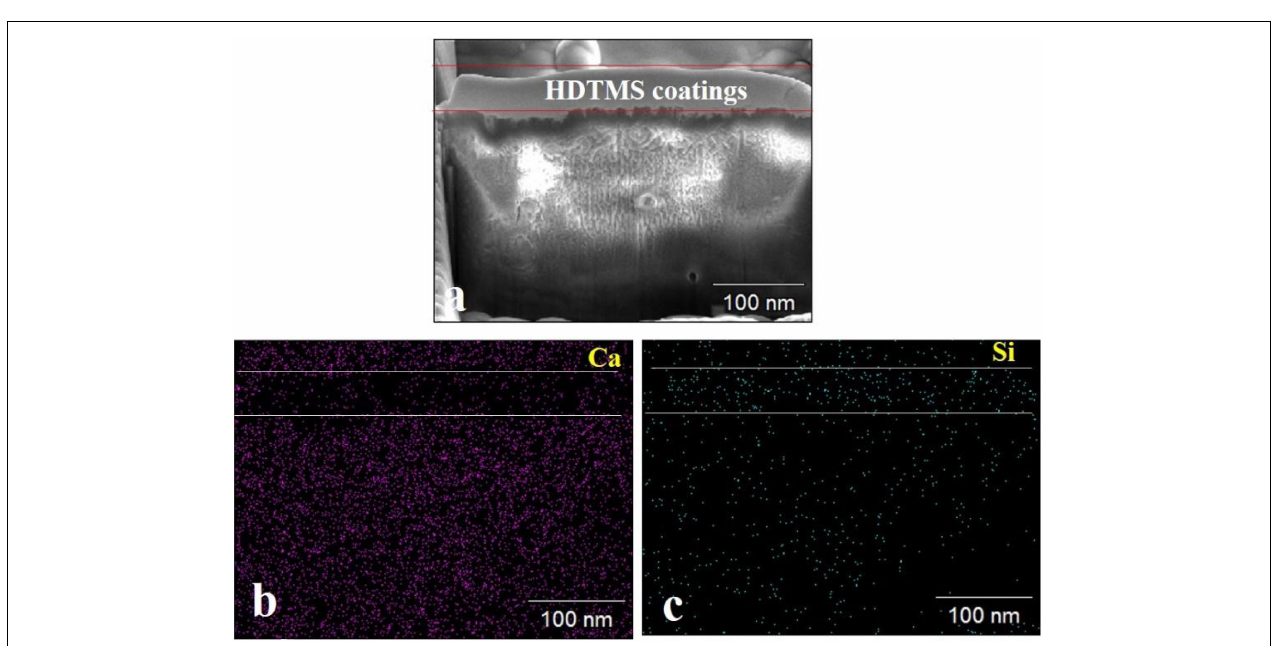
FIGURE 5 | Cross-sectional SEM images of the HDTMS/calcite coating and the distribution of relevant elements. (a) Cross-sectional SEM images of the HDTMS/calcite coating. (b) Distributions of Ca and (c) distributions of Si of the HDTMS/calcite coating.